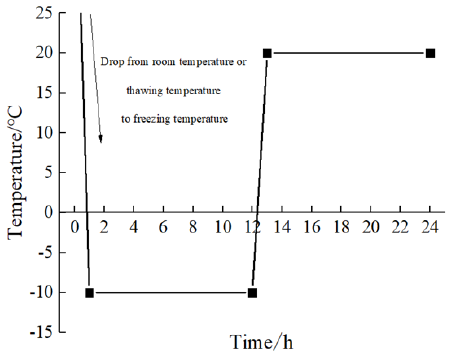
Figure 2. Temperature change curve of each freeze-thaw cycle.